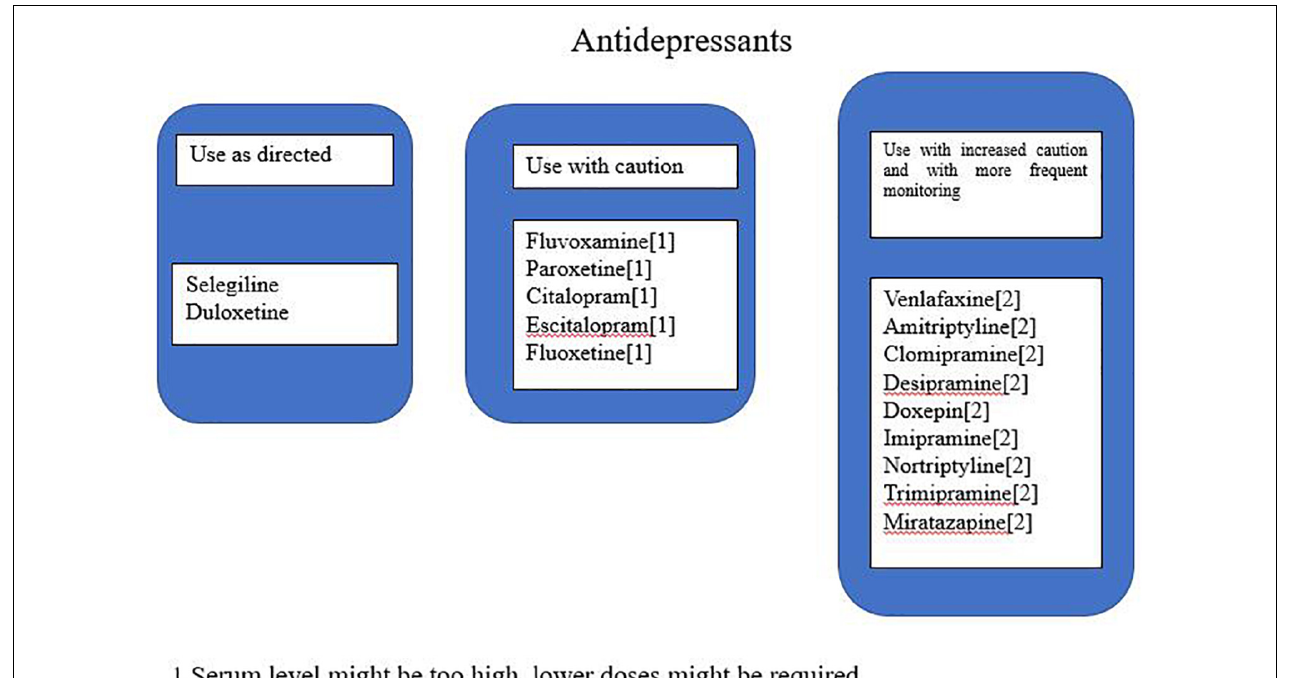
FIGURE 1 | An example of a report for one